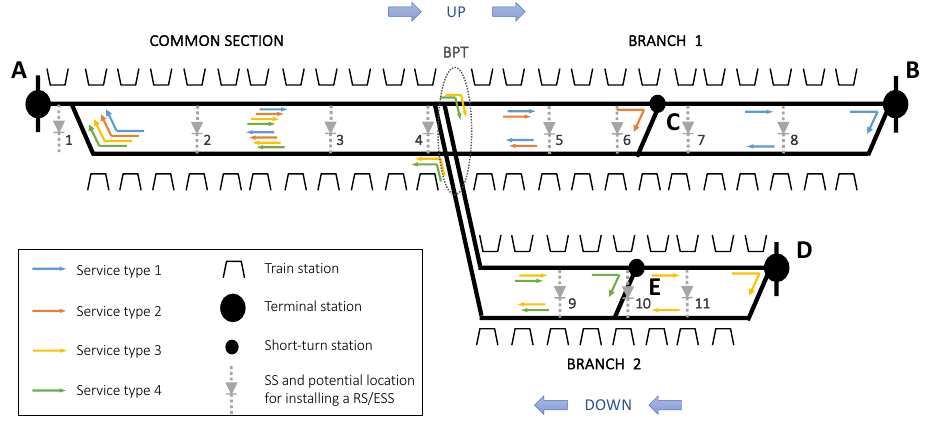
Figure 4. Case study line’s